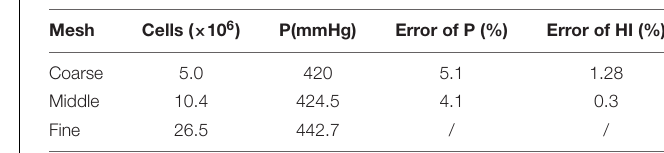
TABLE 5 | Results of grid sensitivity